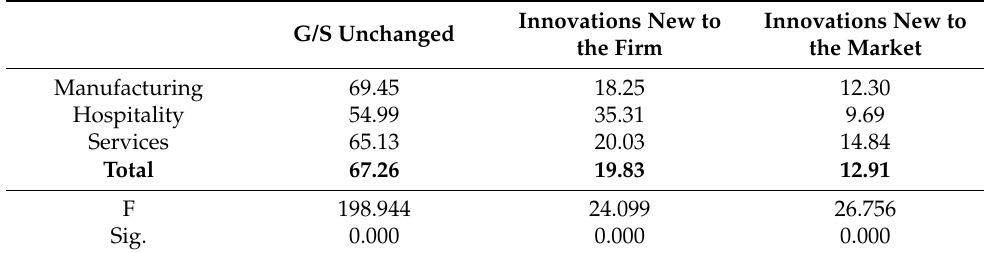
Table 13. Distribution of total turnover by industry (%) and ANOVA. G/S